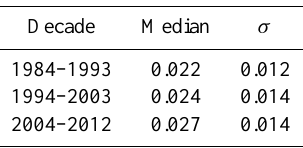
Table 4. Median and standard deviation ( σ ) of the monthly-mean homogenized AOD data set during wintertime (December, January and